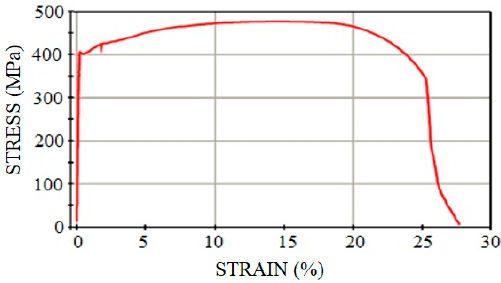
Figure 8. Stress-strain curve for a coupon from plate 8 mm + tube 4 mm.